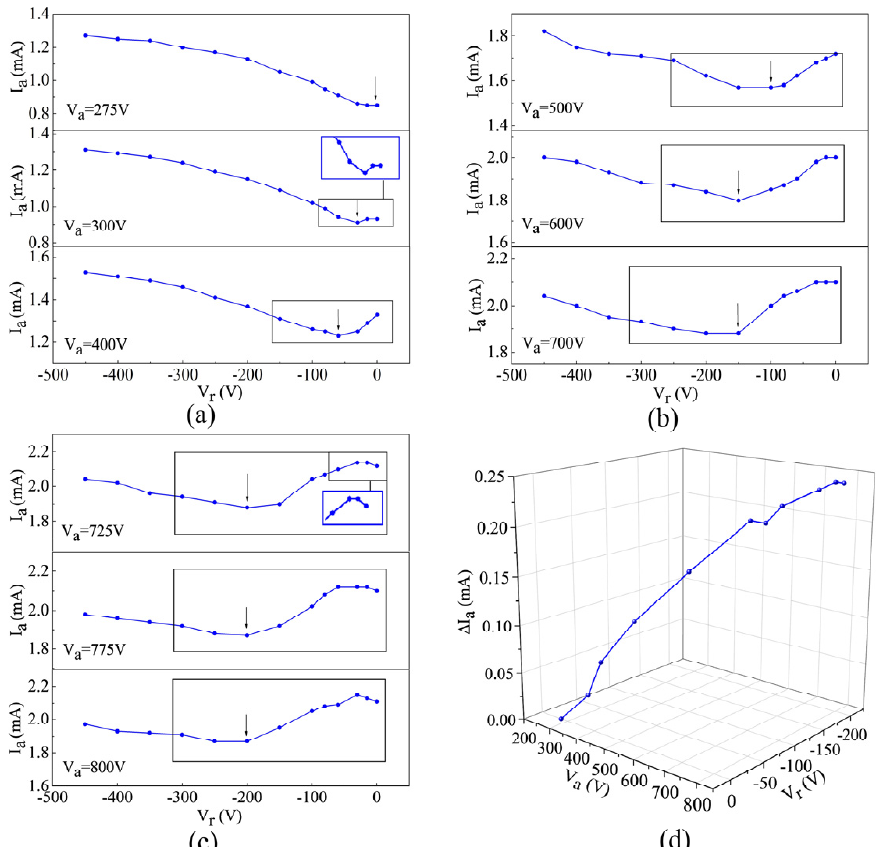
Figure 3. I a corresponding to different respective anode voltage V a as a function of the repeller voltage V r , where ( a ) V a = 275 V, V a = 300 V (inset: close-up of the variation of I a ), V a = 400 V; ( b ) V a = 500 V, V a = 600 V, V a = 700 V; ( c ) V a = 725 V (inset: close-up of the variation of I a ), V a = 775 V, V a = 800 V; ( d ) ∆ I a as a function of V a and V r .